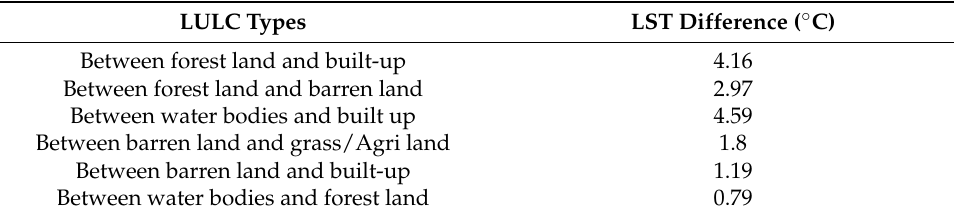
Table 4. The LST difference between LULC